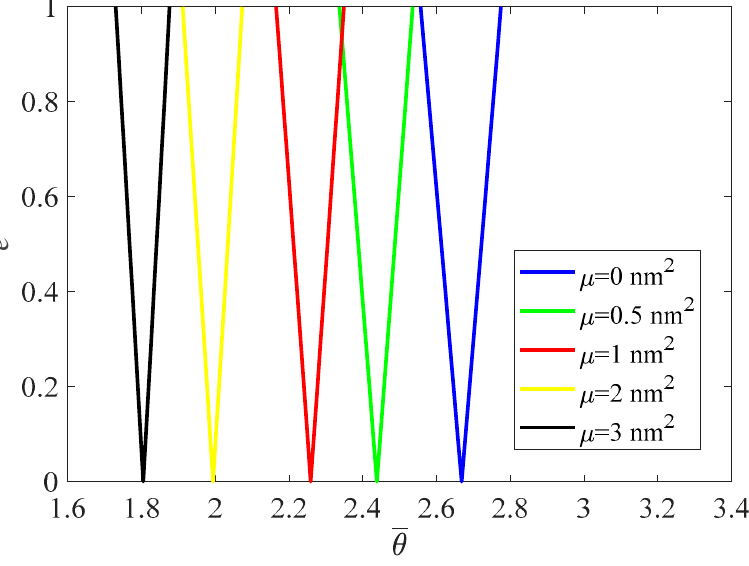
Figure 5. PIRs under various nonlocal parameter.